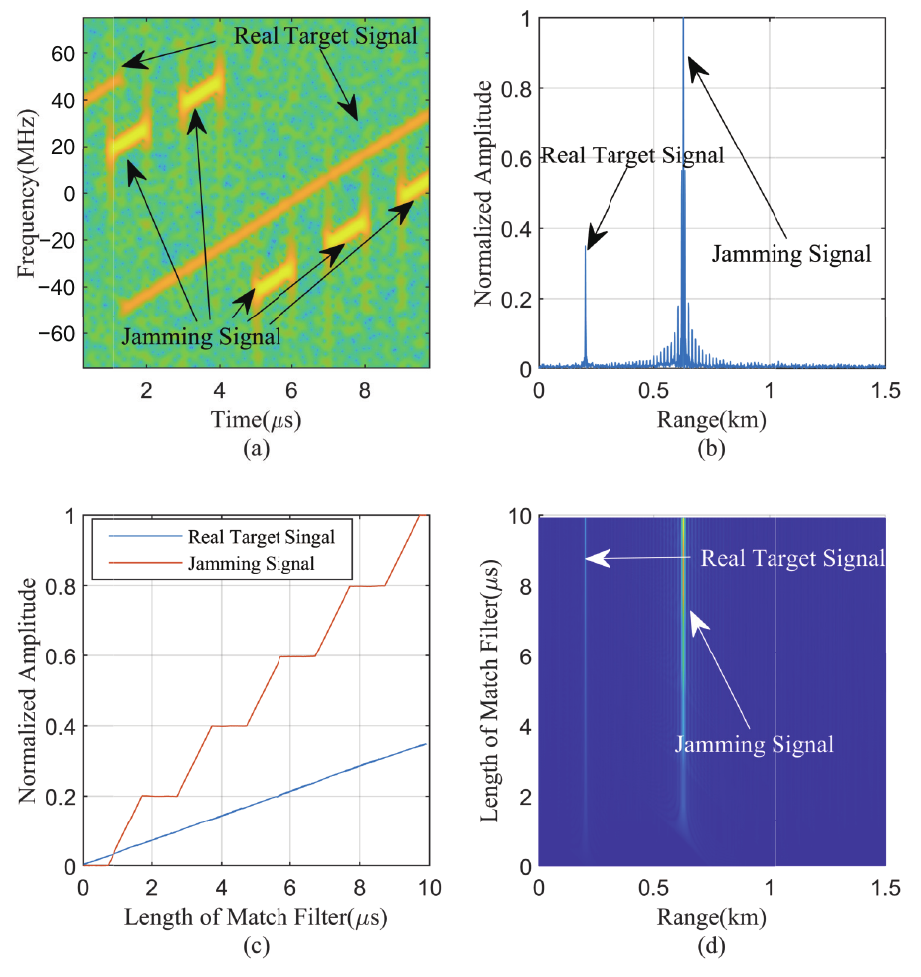
Figure 2. Comparison of different characters between real target signal and jamming signal. ( a ) The TF analysis; ( b ) the pulse compression results filtered with the full-length matched filter; ( c ) the pulse compression results versus the lengths of matched filters; ( d ) the TMF matrix. Table 1. Simulation